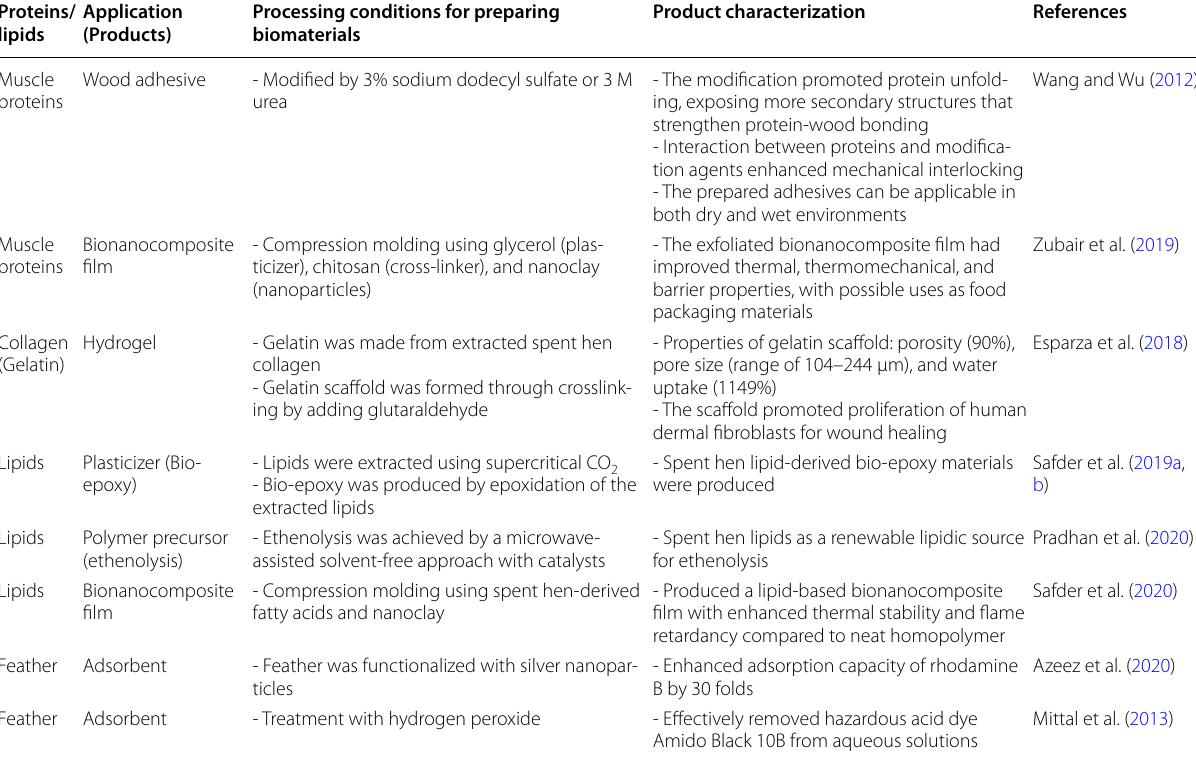
Table 3 Biomaterial applications of spent hen proteins and lipids Proteins/